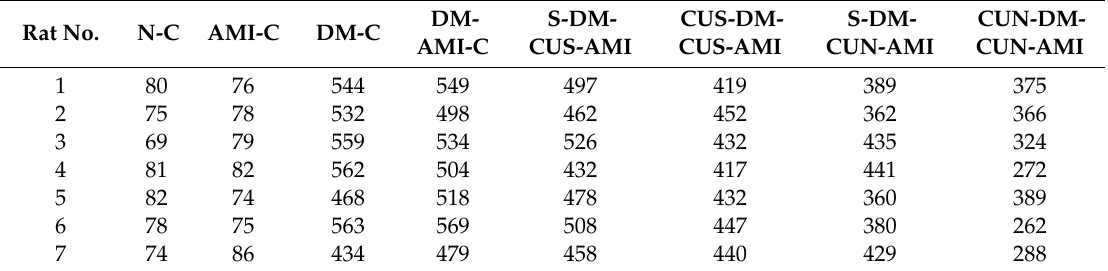
Table 2. Glycaemia levels (mg / dL) for all the rats at 48 h after streptozotocin administration. Rat